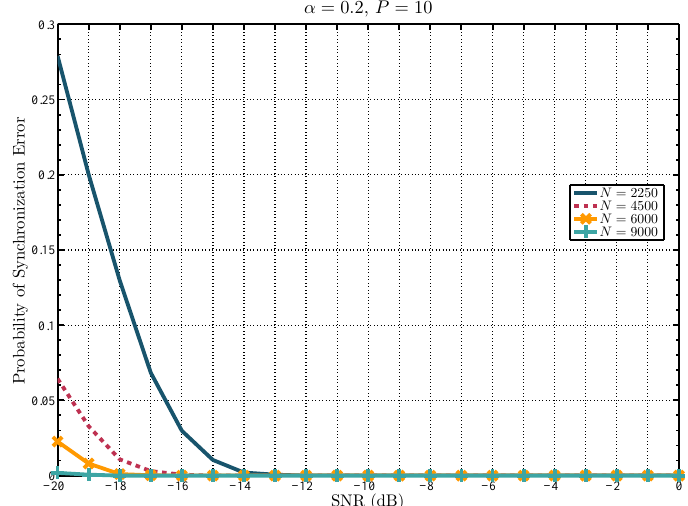
Figure 3. Probability of synchronization error against signal-to-noise ratio